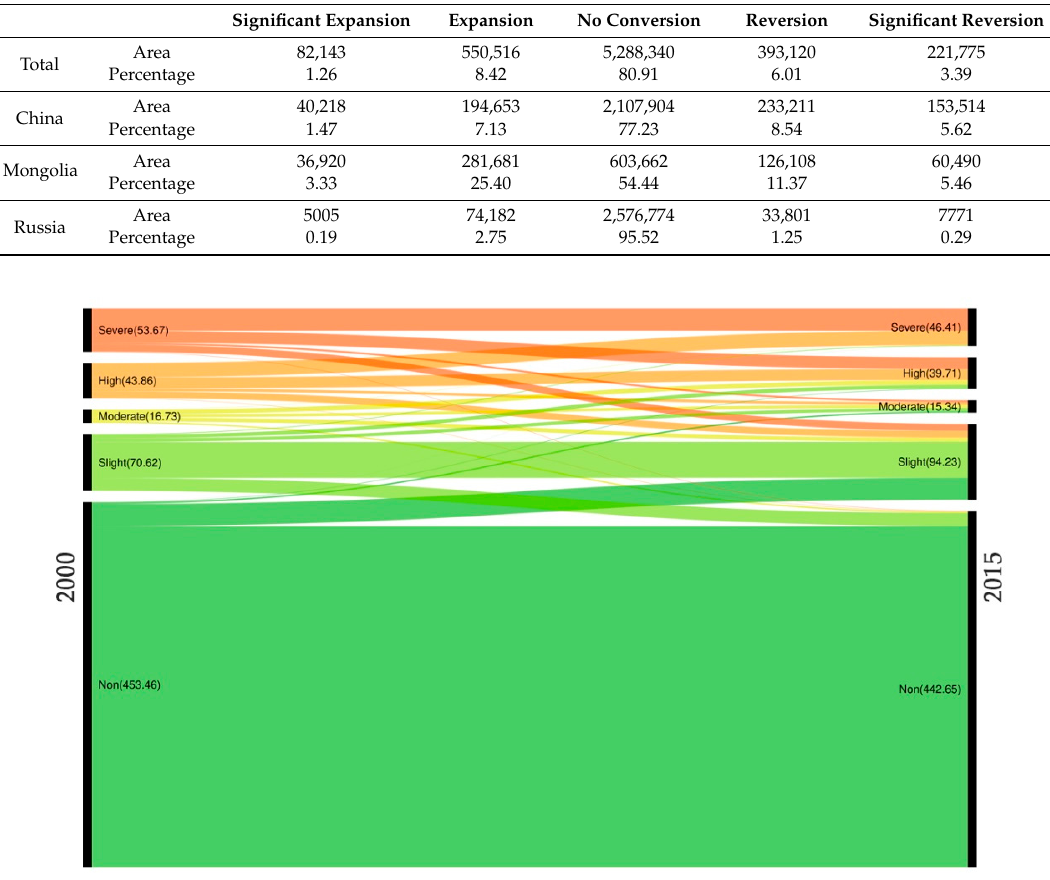
Figure 6. Sankey plot showing conversions from one desertification status to another between 2000 and 2015. The left and right axes of this plot are the area of the desertification status in 2000 and 2015, respectively. The band width represents the size of the converted area (Unit: 10 4 km 2 ) from 2000 to 2015.